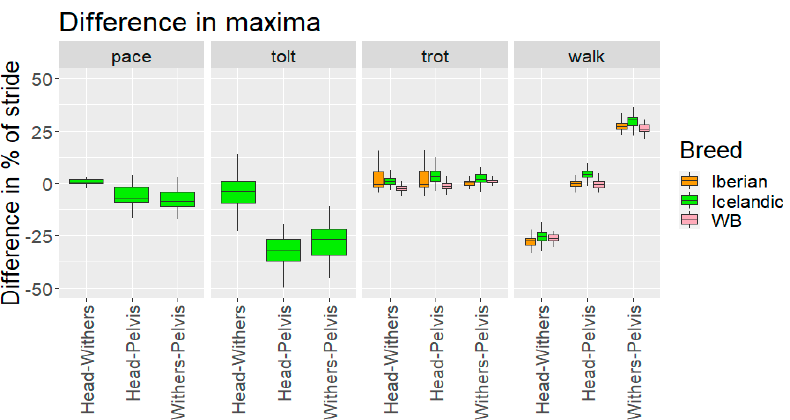
Figure 8. Timing difference in vertical displacement maxima between head, withers and pelvis for the different breeds and gaits studied. WB: Warmblood horses. A positive Head–Withers value indicates that the head reaches the minima first. A positive Head–Pelvis means the head reaches the minima first. A positive Withers–Pelvis means the withers reaches the minima first.